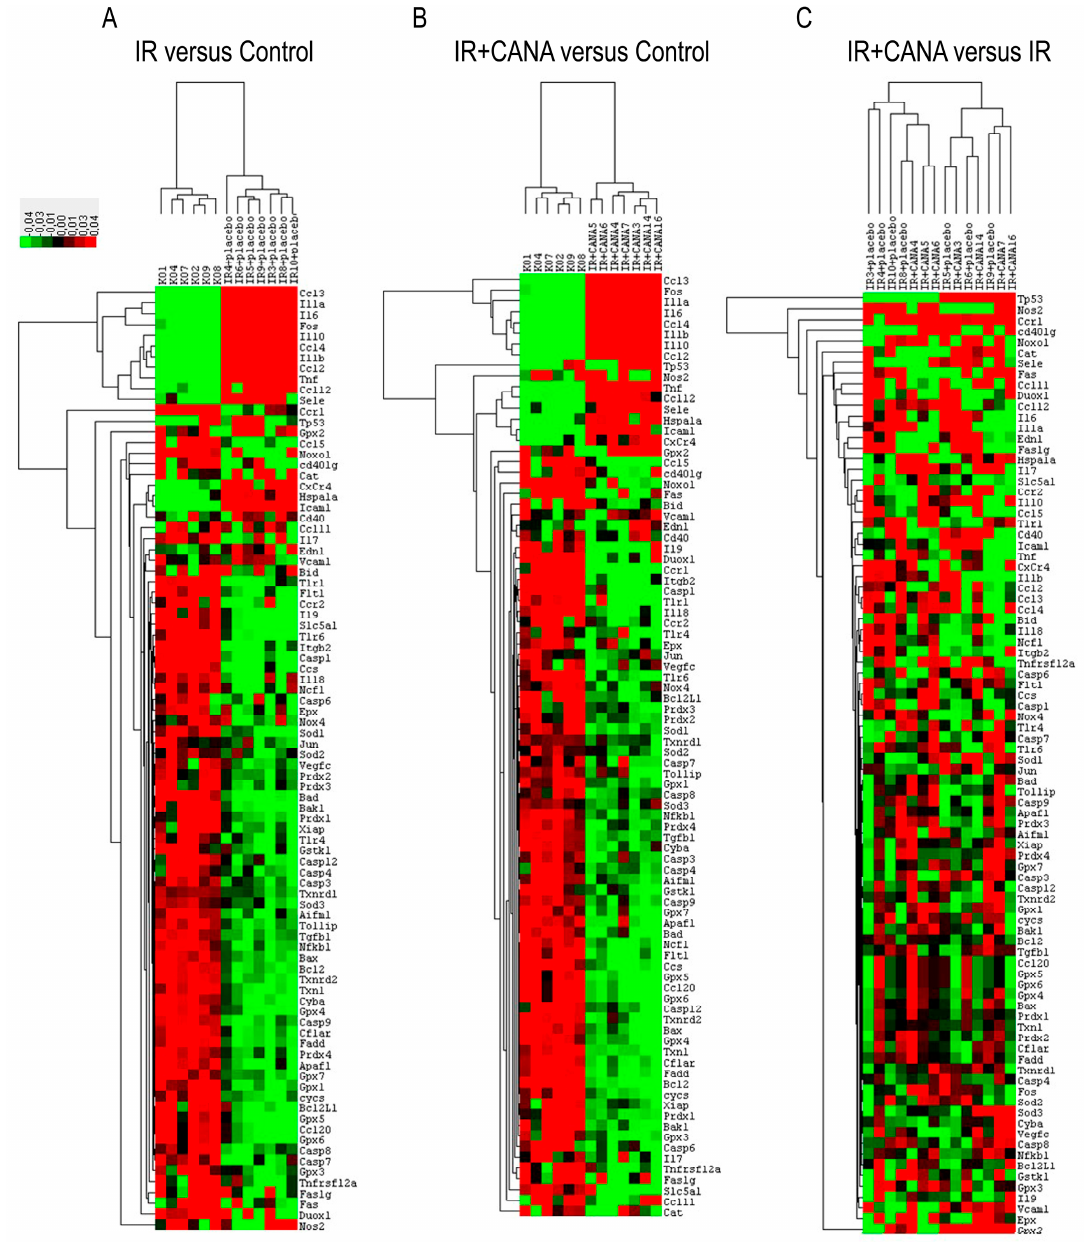
Figure 2. Changes in gene expression caused by vascular ischemia/reperfusion (IR) injury and the effect of canagliflozin (CANA). The expression of 88 genes involved in inflammation, apoptosis, and oxidative stress has been profiled. Clustergrams create a heat map with dendograms to indicate which genes are coregulated. Degrees of red and green indicate relatively high and low expression of the corresponding gene, respectively, and black squares denote genes equally expressed. ( A ) IR vs. Control, ( B ) IR + CANA vs. Control, and ( C ) IR + CANA vs. IR groups. The x-axis indicates number of rats (“KO” corresponds to the Control group, including six rats (KO1, KO2, KO4, KO7, KO8, KO9), “IR + placebo” corresponds to the IR group, including seven rats (IR3 + placebo, IR4 + placebo, IR5 + placebo, IR6 + placebo, IR8 + placebo, IR9 + placebo, IR10 + placebo), and “IR + CANA” corresponds to the IR + canagliflozin group, including seven rats (IR + CANA3, IR + CANA4, IR + CANA5, IR + CANA6, IR + CANA7, IR + CANA14, IR + CANA16)) and the y-axis indicates the genes. n= 6–7 rats/group. See Table 1 for genes’ abbreviations.